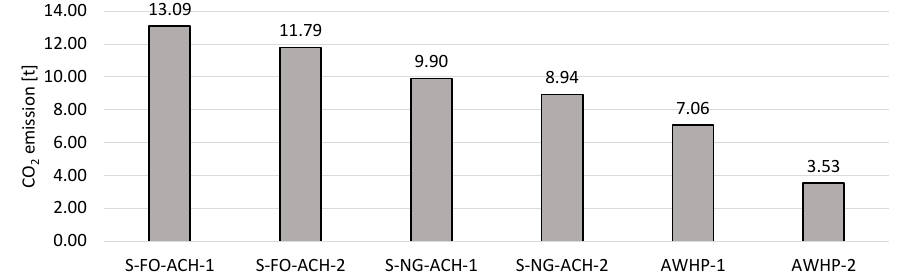
Figure 13. Annual CO 2 emissions for operation of HVAC systems. Costs during the lifetime of HVAC systems for three scenarios of energy prices are presented in Figure 14. The investment cost is introduced in the starting year. The lowest lifetime cost for all the energy price scenarios is achieved with the imple- mentation of a PV plant in an AWHP-based HVAC (AWHP-2) system. The payback period for the AWHP-2 system varies depending on the price of electricity. The longest payback period of 7 years is achieved in scenario 1 with the lowest electricity price. The payback period decreases further to 3.5 years (scenario 2) and 2.5 years (scenario 3). Absorption SHC systems cannot match the lifetime costs of AWHP systems due to the higher investment costs. As mentioned earlier, these systems could only be competitive with the AWHP system in a scenario with increased electricity prices and drastically reduced investment costs for such systems. This scenario is simulated in Figure 15, using investment cost for absorption SHC systems of 80,000 EUR. In this scenario, the system S-NG-ACH-2 achieves the lowest lifetime